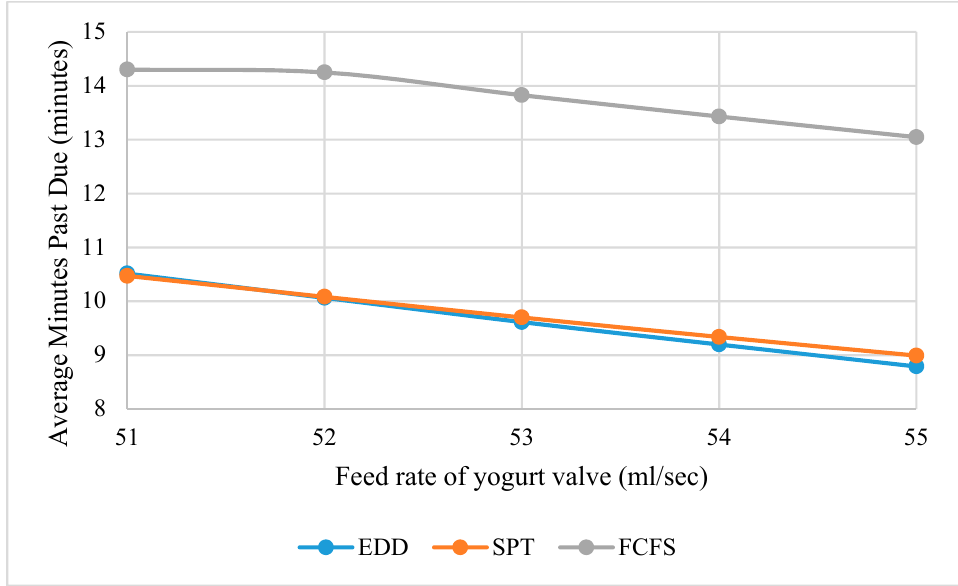
Figure 11. The effect of feed rate of yogurt valve on average minutes past due. The three performance measures were investigated while sequencing the cups on the three single-dimensional rules. In the above investigation, the SPT rule is better than EDD and FCFS with respect to average flow time, while FCFS is better than EDD and SPT with respect to average minutes early. Similarly, EDD is better than SPT and FCFS with respect to average minutes past due. As all performance measures are calculated for the single-dimensional rules, the choice of management is to value the average minutes past due (keeping promises to customers) the most, and its lowest values in most cases are in the EDD rule.